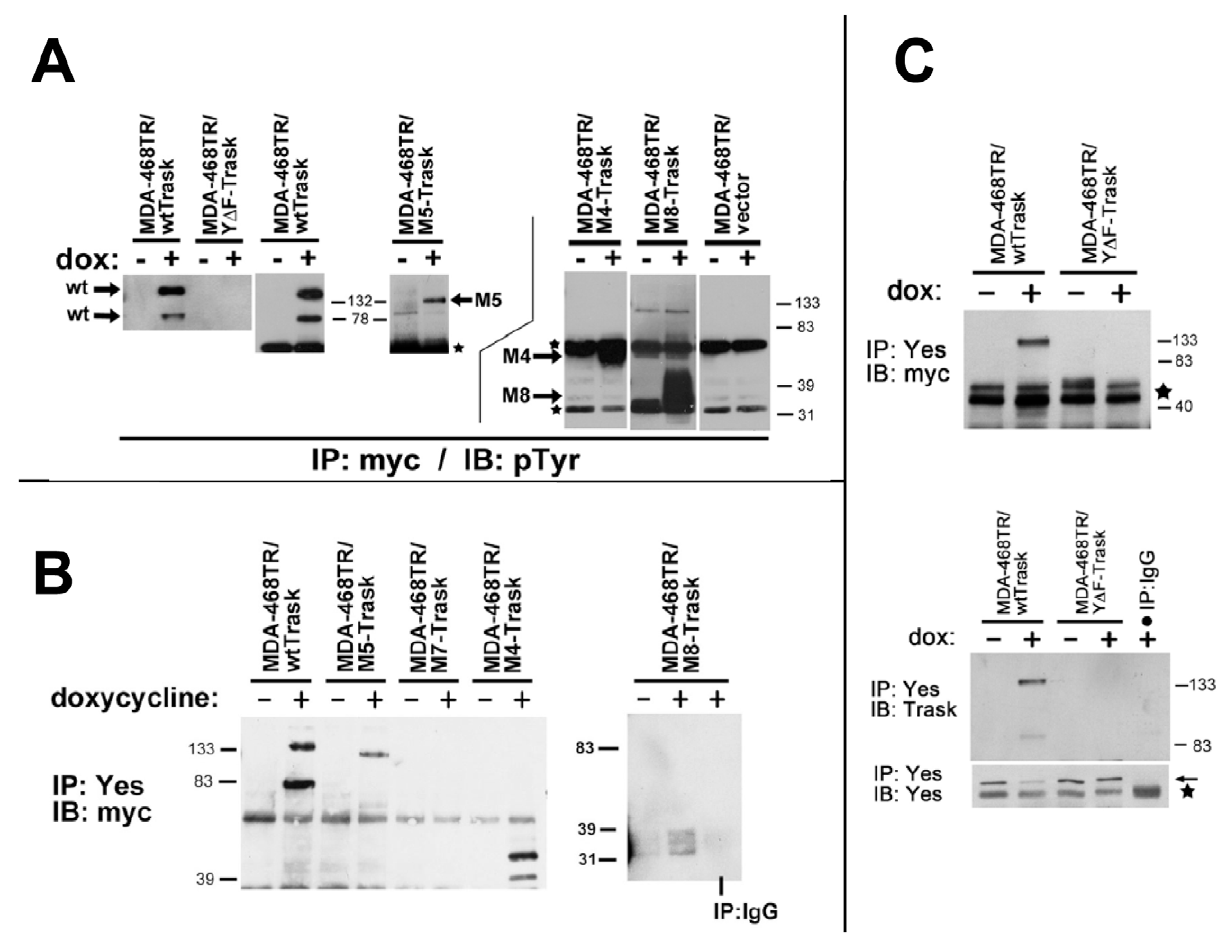
Figure 3. Signaling properties of Trask mutants. A ) The induced constructs were immunoprecipitated by anti-myc antibodies from the engineered transfectants cell types and vector control cells and immunoblotted with pTyr antibodies. The lysates from the larger size constructs (wt, Y D F, M5) were run on lower % gels and the smaller size constructs (M4, M8) were run on higher % gels for optimal separation and identification. The bands corresponding to the various constructs are indicated by arrows. The starts indicate the immunoglobulin chains. These blots are representative of multiple experiments (4X for wt, 4X for Y D F, 2X for M5, 2X for M4, 3X for M8, and 2X for vector control). B ) Anti-yes immune complexes were obtained from each of the mutant cell types and immunoblotted using anti-myc antibodies to detect the co-immunoprecipitation of the transfected constructs. The M8 mutant Trask protein appears as 3 bands likely due to the significant effect of differential phosphorylation on the gel migration of this small construct. These blots are representative of multiple experiments (5X for wt, 1X for M5, 2X for M7, 2X for M4, and 3X for M8). C ) The interaction of the Y D F mutant with Yes was similarly assayed as above. The anti-myc immunoblot shows that the Yes-Trask interaction is lost in the Y D F mutant. The immunoblots were redone using anti-Trask antibodies, again confirming that the Yes-Trask interaction is lost in the Y D F mutant. The stars indicates the immunoglobulin chains. The arrows indicate the Yes protein. These blots are representative of three experiments. doi:10.1371/journal.pone.0019154.g003 These data show that the anti-adhesive function of Trask are embodied within the ICD and are entirely dependent on the tyrosine phosphorylation of the ICD. The ECD appears to be dispensible for this function as shown by mutants that lack the ECD. It remains possible that the mutants lacking the ECD inhibit adhesion through a dominant negative mechanism involving the endogenous full length Trask and its ECD. To rule out this possibility we established HEK293 cells with tet-inducible expression of the M4 Trask mutant (Figure 5A). HEK293 cells have no detectable endogenous expression of Trask, enabling us to test the anti-adhesive functions of the Trask ICD directly and definitively, ruling out a potential orthogonal role for the endogenous Trask ECD. Expression of the Trask M4 mutant in these cells leads to a profound inhibition of cell adhesion (Figure 5B). This confirms that the anti-adhesive functions of Trask are contained entirely within its ICD.